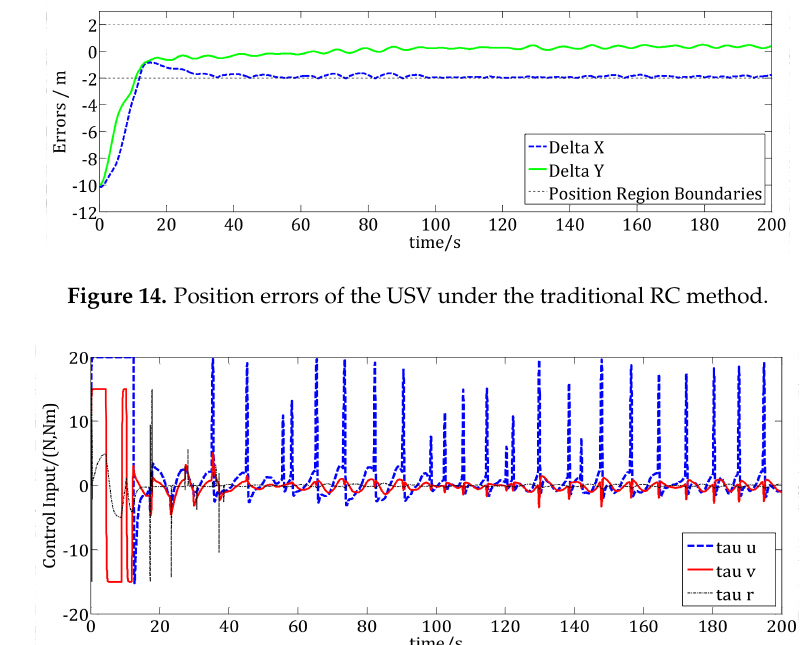
Figure 13. Trajectory tracking results under the traditional RC method.